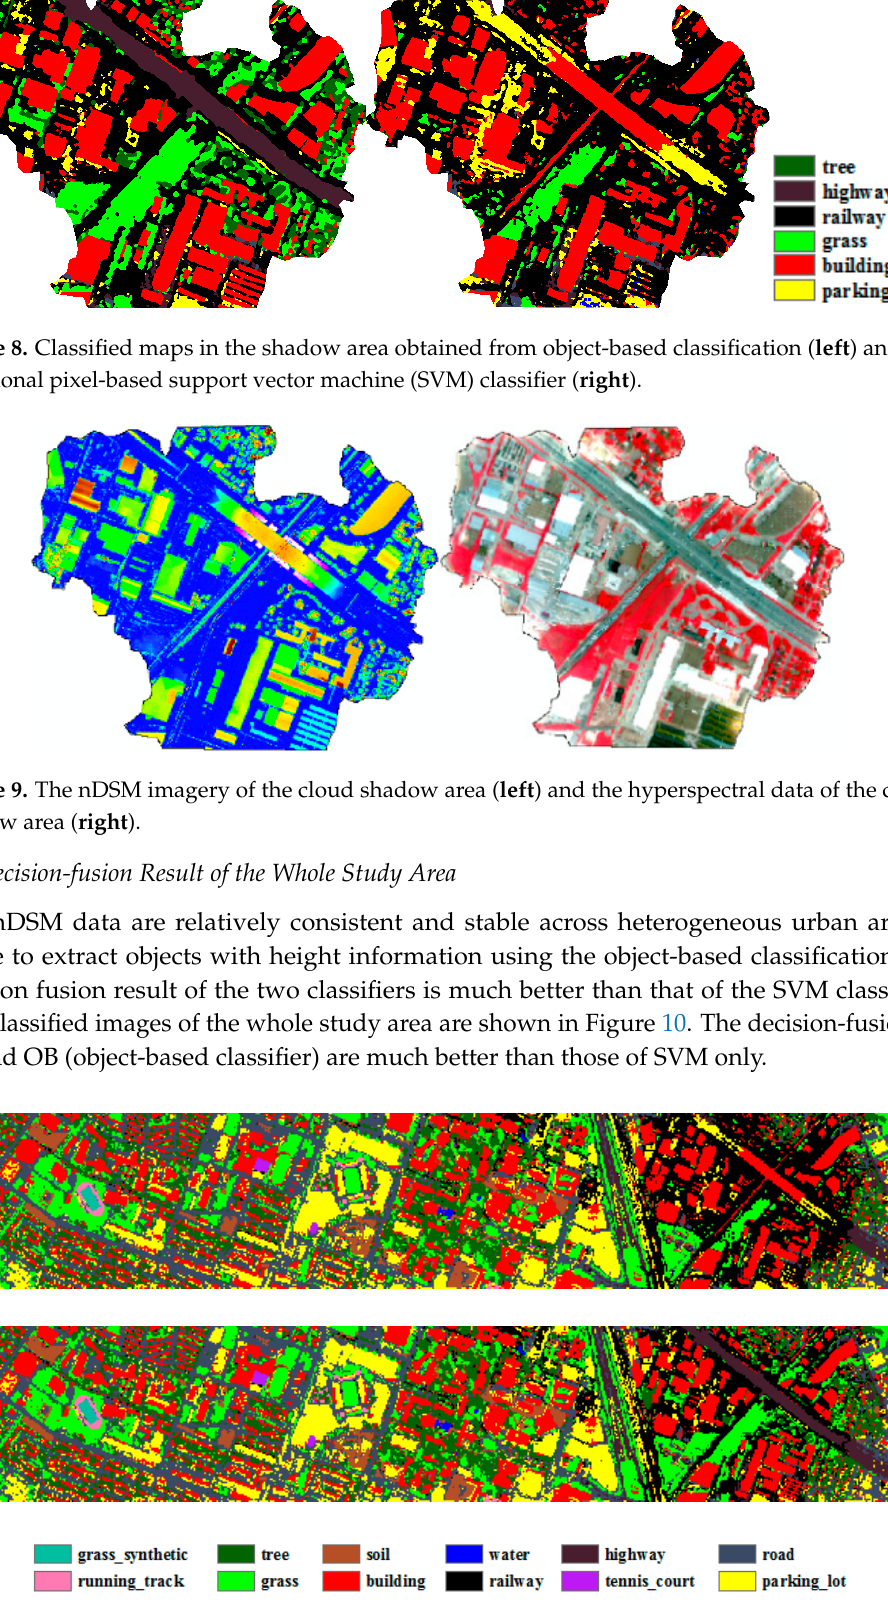
Figure 10. The traditional pixel-based SVM classified map of the whole study area ( top ) and the final decision fusion classification map ( bottom